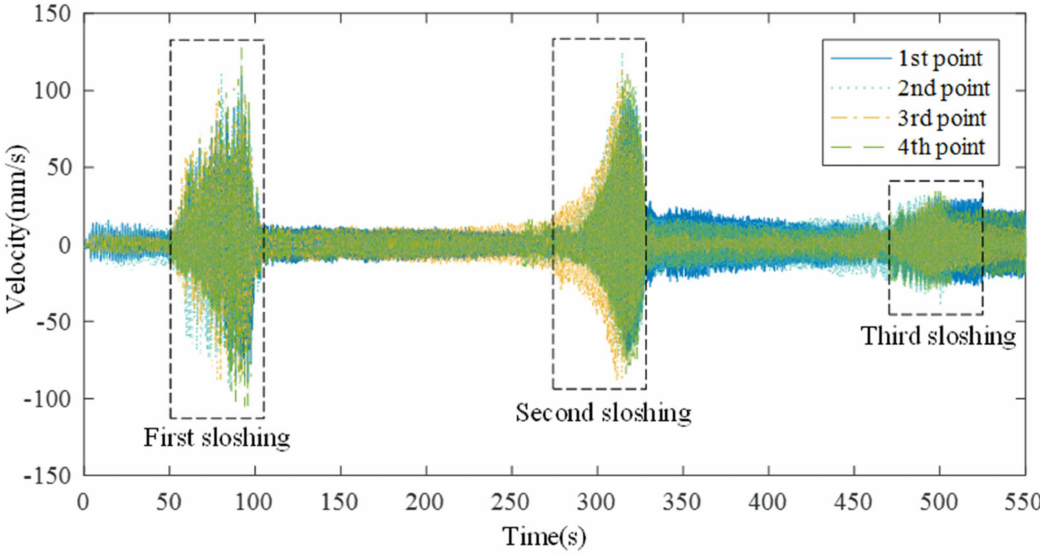
Figure 10. Measured data set of 4 different measurement points.